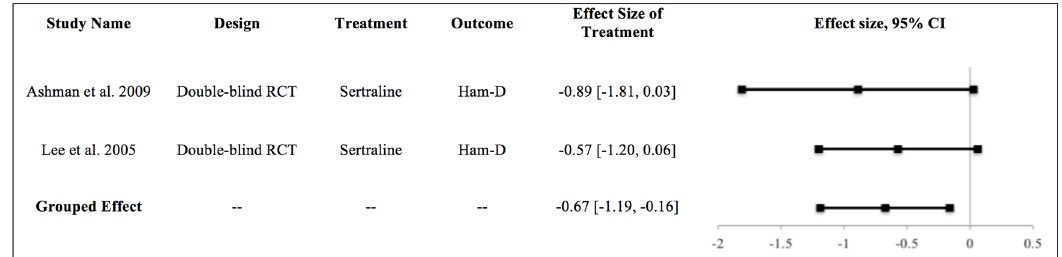
Figure 2. Meta-analysis of all double-blind, randomized controlled trials of sertraline versus placebo ( n = 2), using the Hamilton Depression Rating Scale as the outcome. Effect sizes are reported for the treatment group (sertraline). CI, confidence interval; Ham-D, Hamilton Depression Rating Scale; RCT, randomized controlled trial.